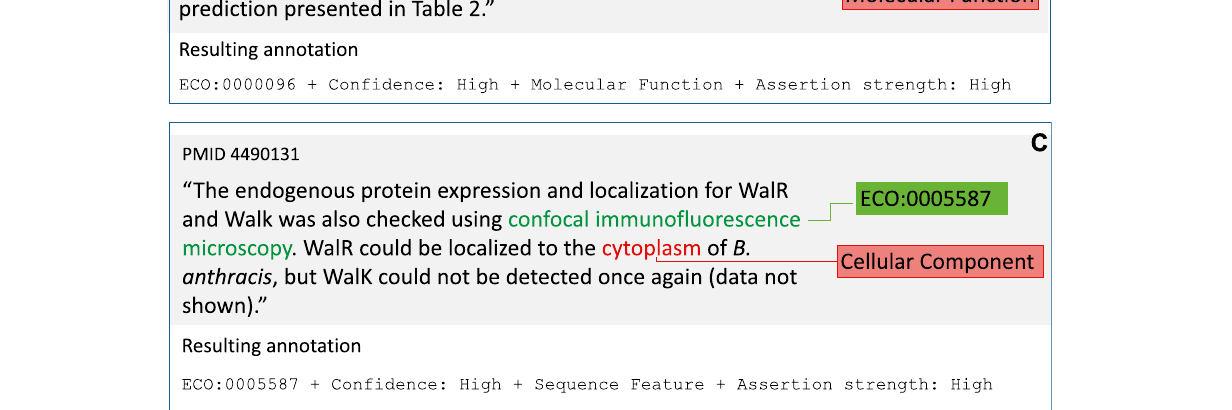
Frontiers in Research Metrics and Analytics |